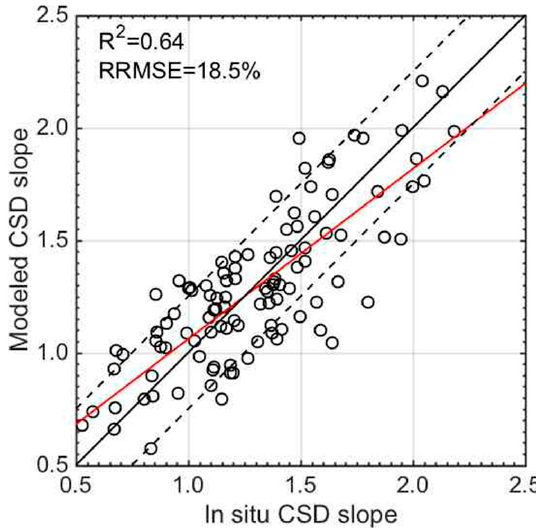
Figure 6. Comparison of in situ CSD slope determined from in situ Chl a size and modeled CSD slope